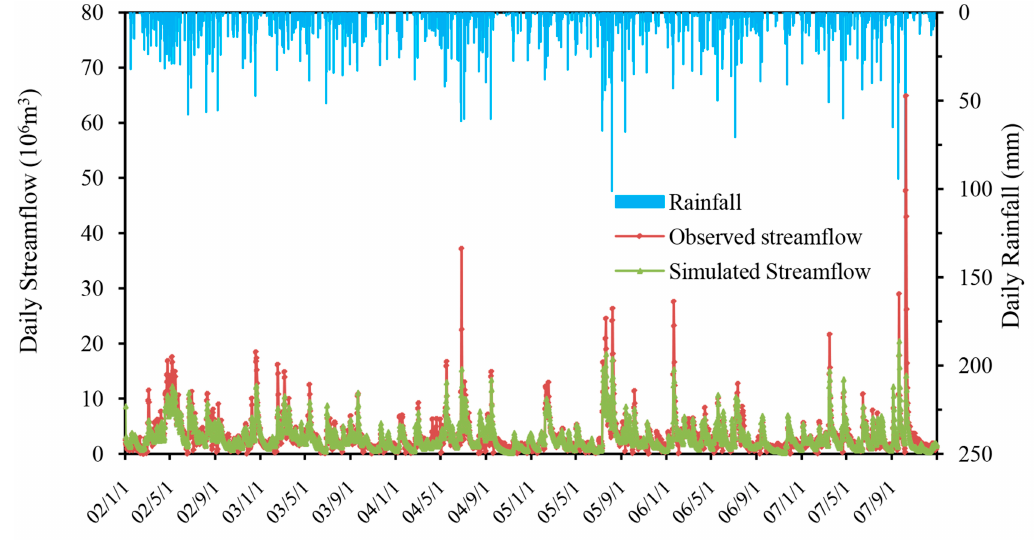
Figure 5. Comparison between simulated and observed monthly streamflow in the Xitiaoxi watershed during the calibration period (1 January 2002–31 December 2007).